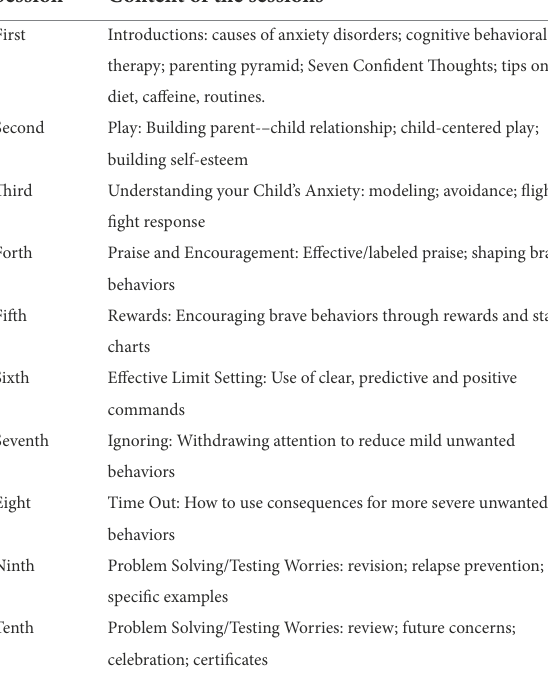
TABLE 5 Descriptive statistics of anxiety and family accommodation scores in pre-test, post-test, and follow-up assessments.